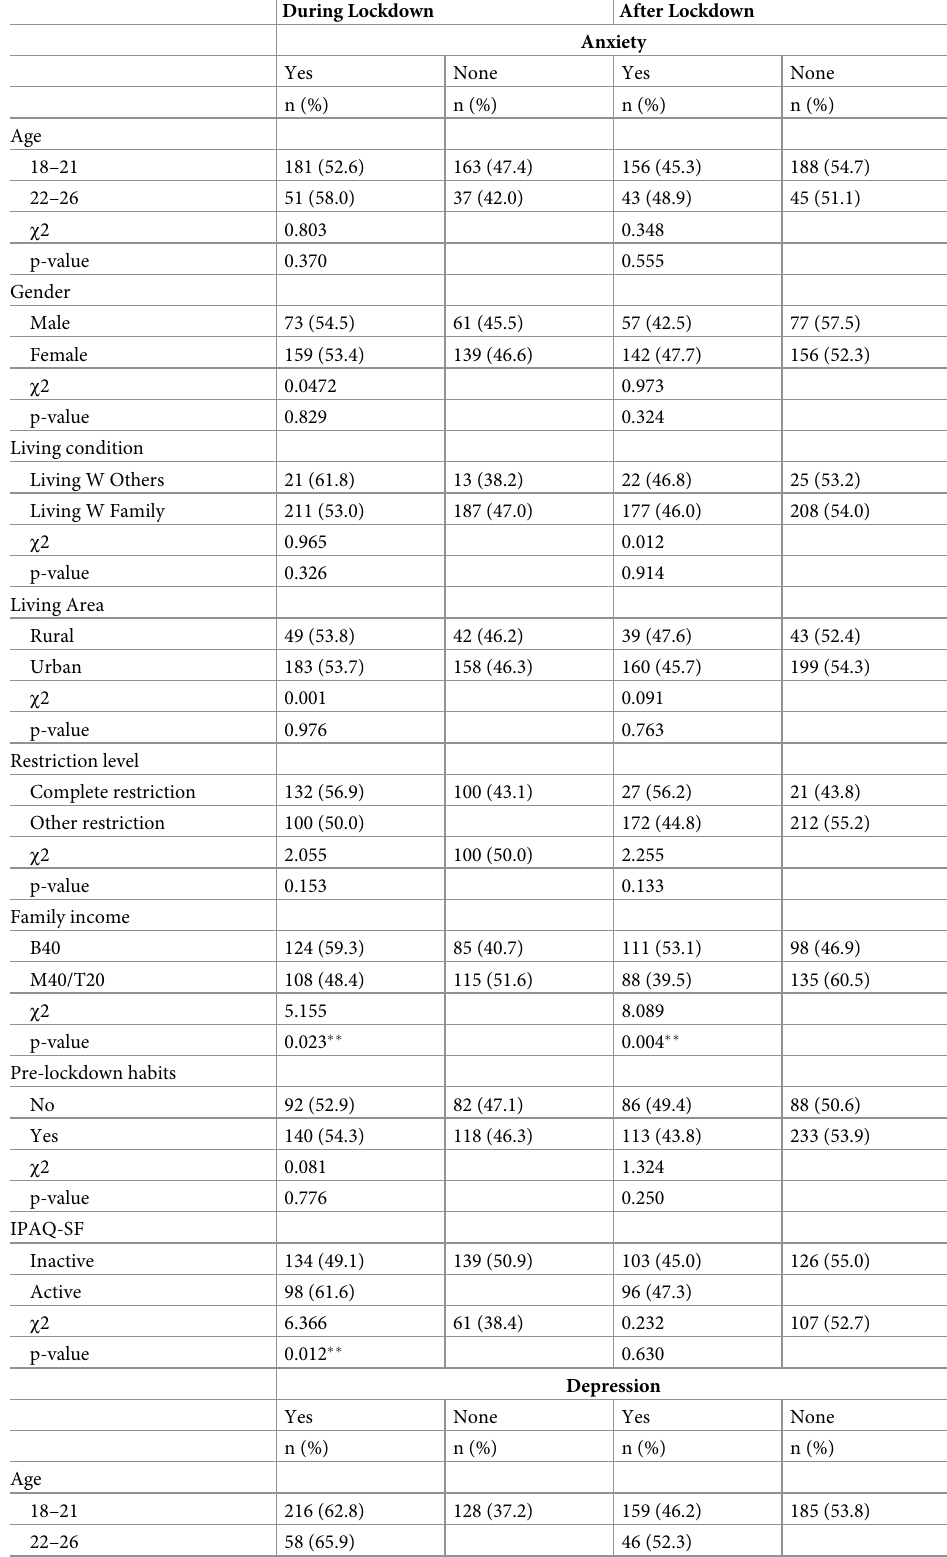
Table 3. Association of anxiety and depression with participant